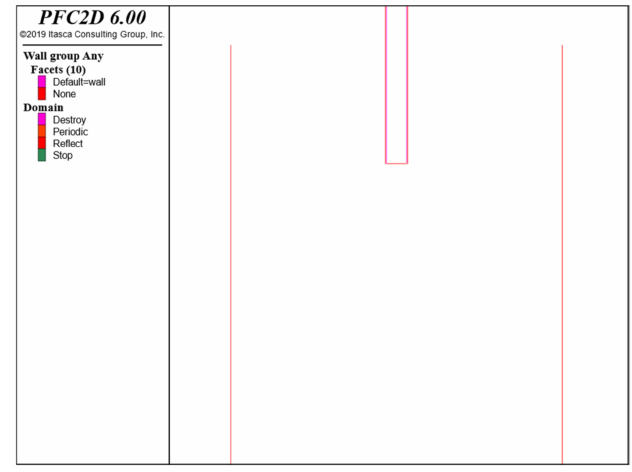
Figure 4. Soil container and pile model from the DEM